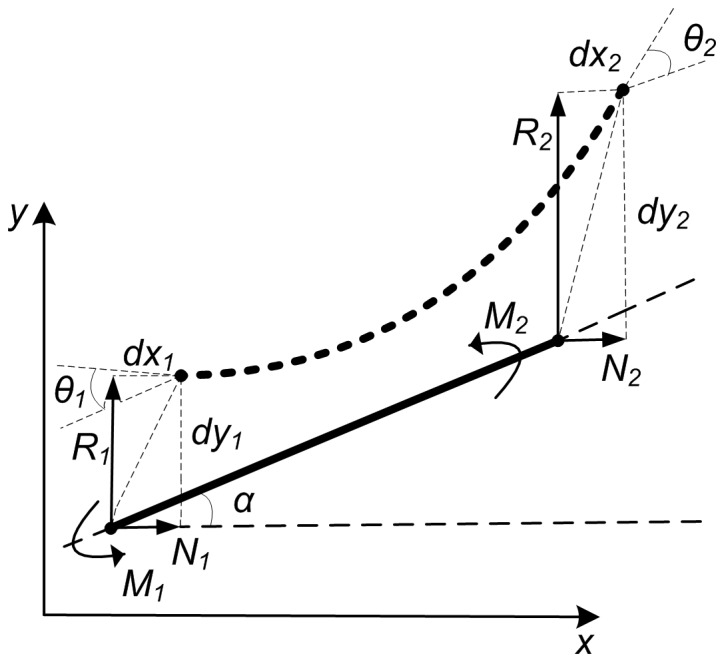
Force analysis of a beam element.
 and  refer to the forces and moments applied to the end nodes, and  and  provide the displacements and rotations of the two end nodes.